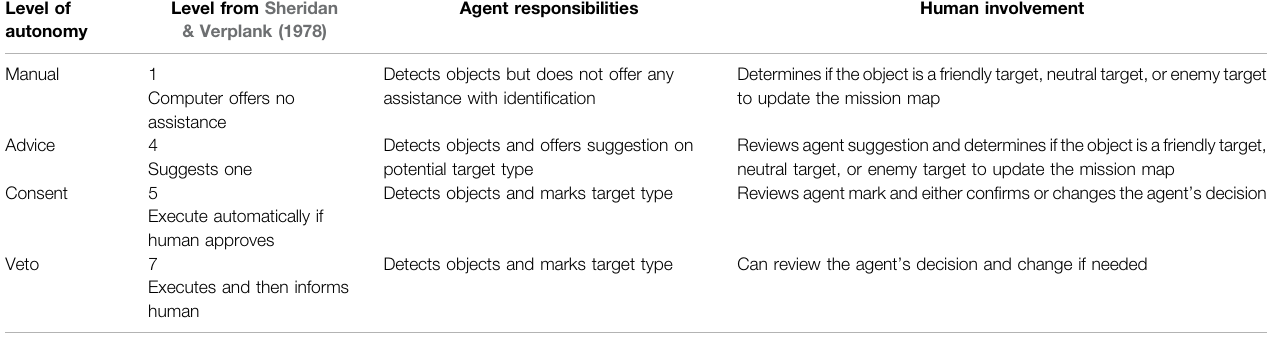
TABLE 2 | Level of autonomy conditions.